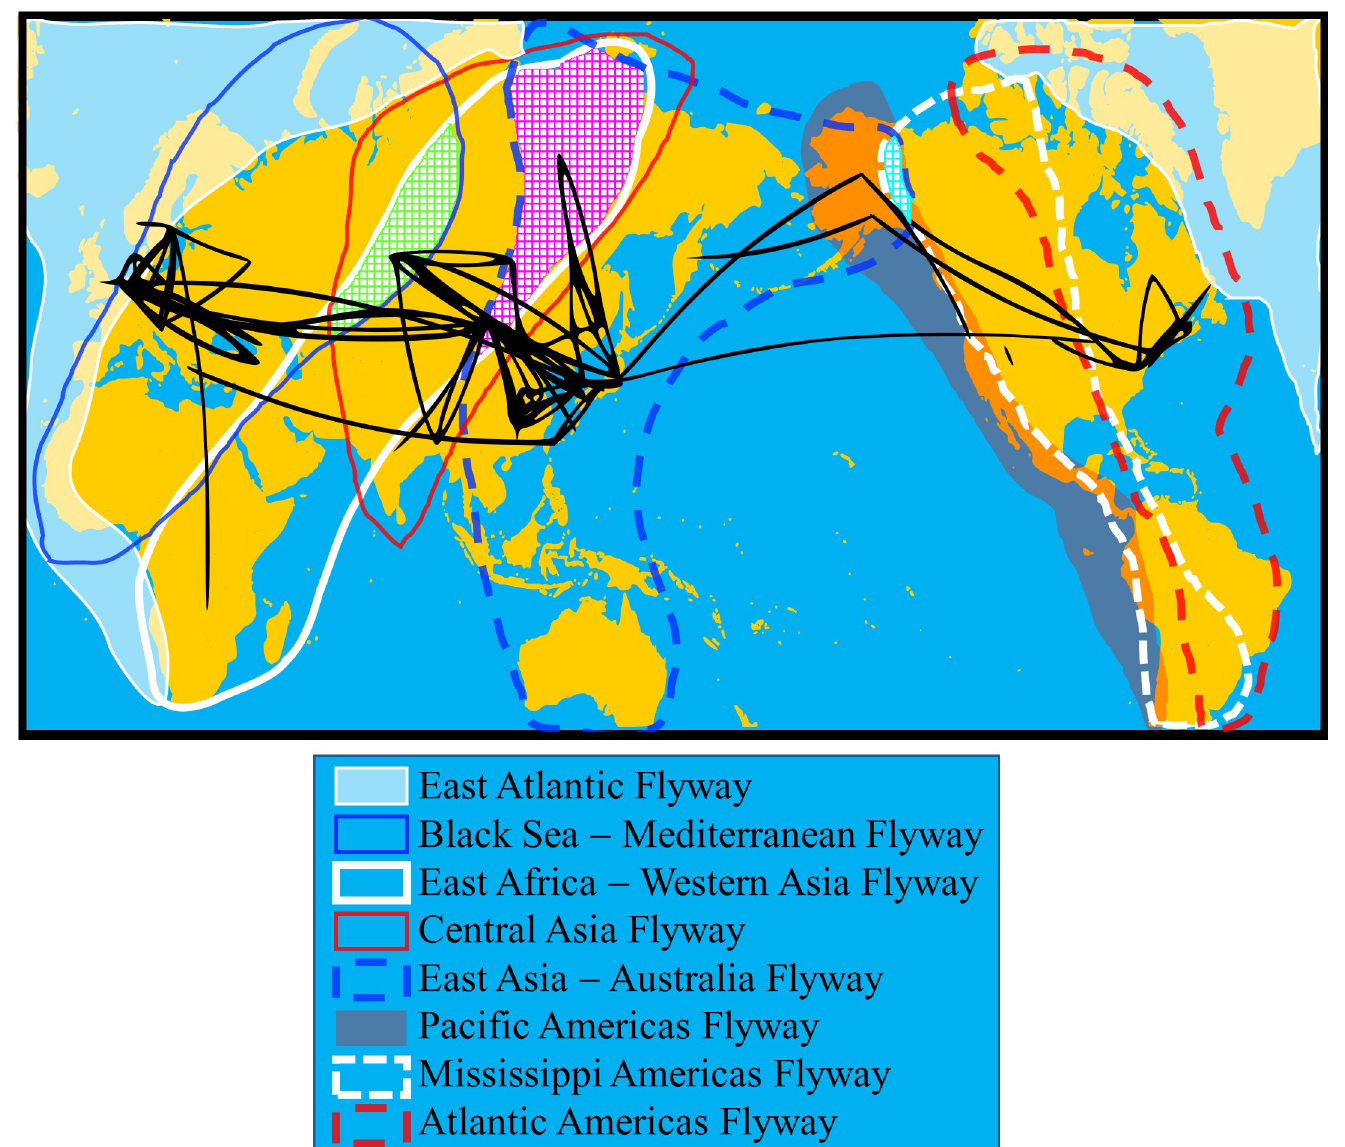
Fig 8. Visualization of relationship between movement of shorebirds and spread of avian influenza viruses. Location-annotated maximum clade credibility trees for all selected clades (A–Q) on a world map were merged with previously reported flyways of shorebirds [47]. Regions where 3 flyways overlap are shaded.